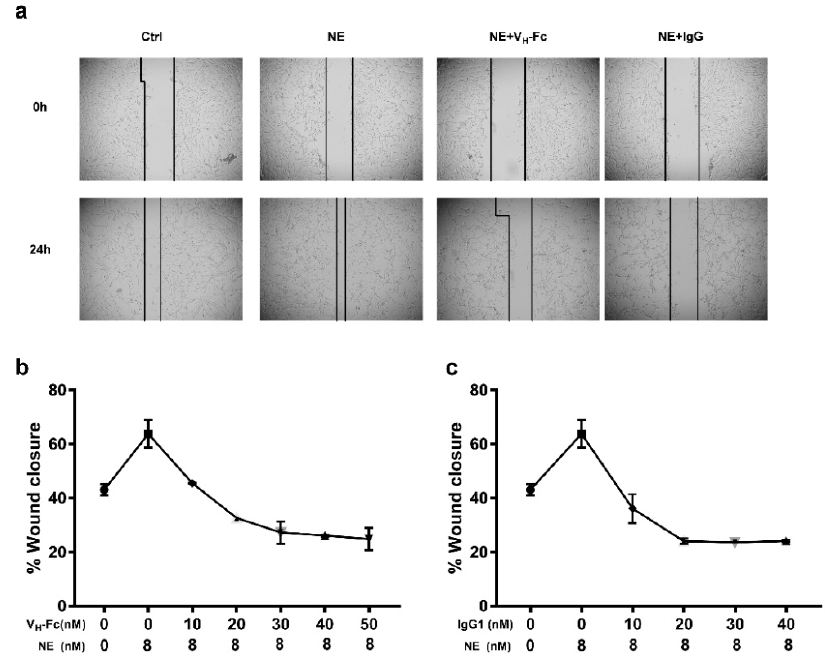
Figure 5. V H -Fc 1D1.43 and IgG1 1C10 inhibited NE-promoted fibroblast differentiation. ( a ) Representative pictures of wound-healing assay. LL47 fibroblasts were plated into a 24-well plate and scratched, treated with 8 nM NE with or without antibody proteins at different concentrations for 24 h. ( b , c ) V H -Fc 1D1.43 ( b ) and IgG1 1C10 ( c ) inhibited NE-promoted LL 47 fibroblast differentiation. Experiments were performed in duplicate. Values were reported as the mean of percent wound closure ±